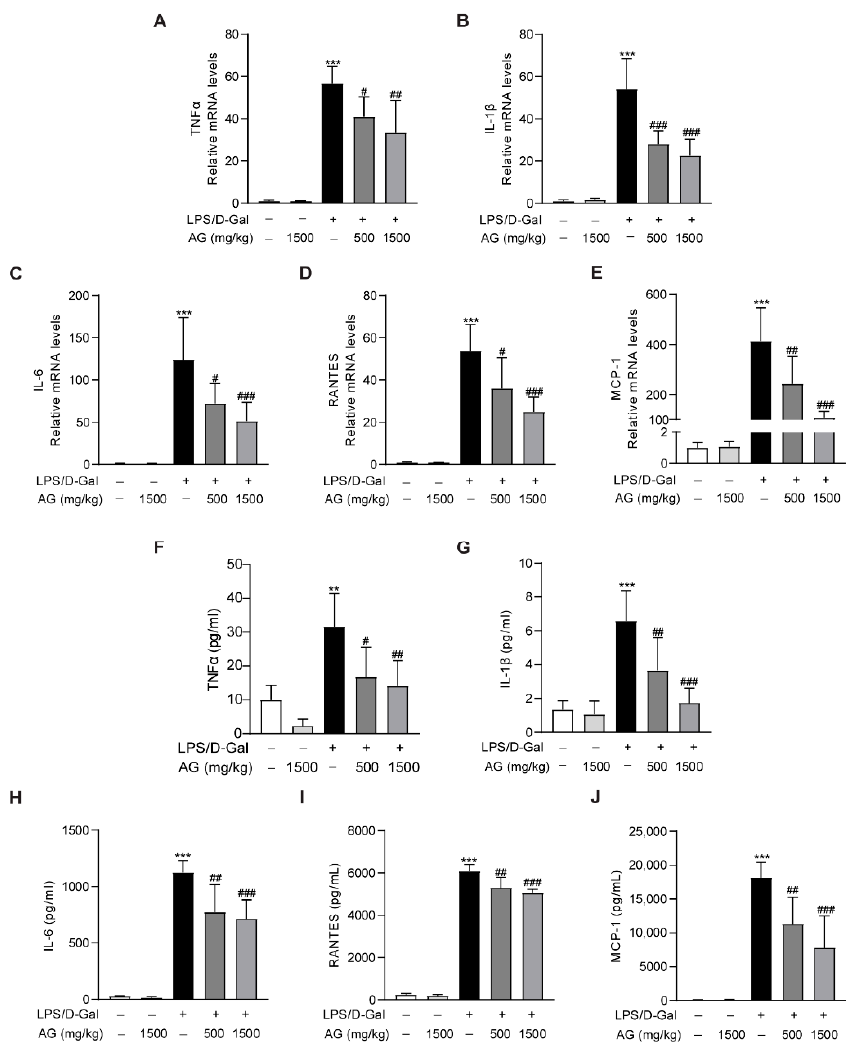
Figure 5. Impact of Ala-Gln on LPS/D-Gal-induced inflammatory responses in liver and plasma. ( A – E ) mRNA expression levels of TNF- α , IL-1 β , IL-6, RANTES, and MCP-1 in liver tissues. ( F – J ) Protein levels of TNF- α , IL-1 β , IL-6, RANTES, and MCP-1 in plasma. Data are expressed as mean ± SD, n = 6–8 in each group. ** p < 0.01, *** p < 0.001 vs. vehicle-treated control group, # p < 0.05, ## p < 0.01, ### p < 0.001 vs. LPS/D-Gal-treated model group.